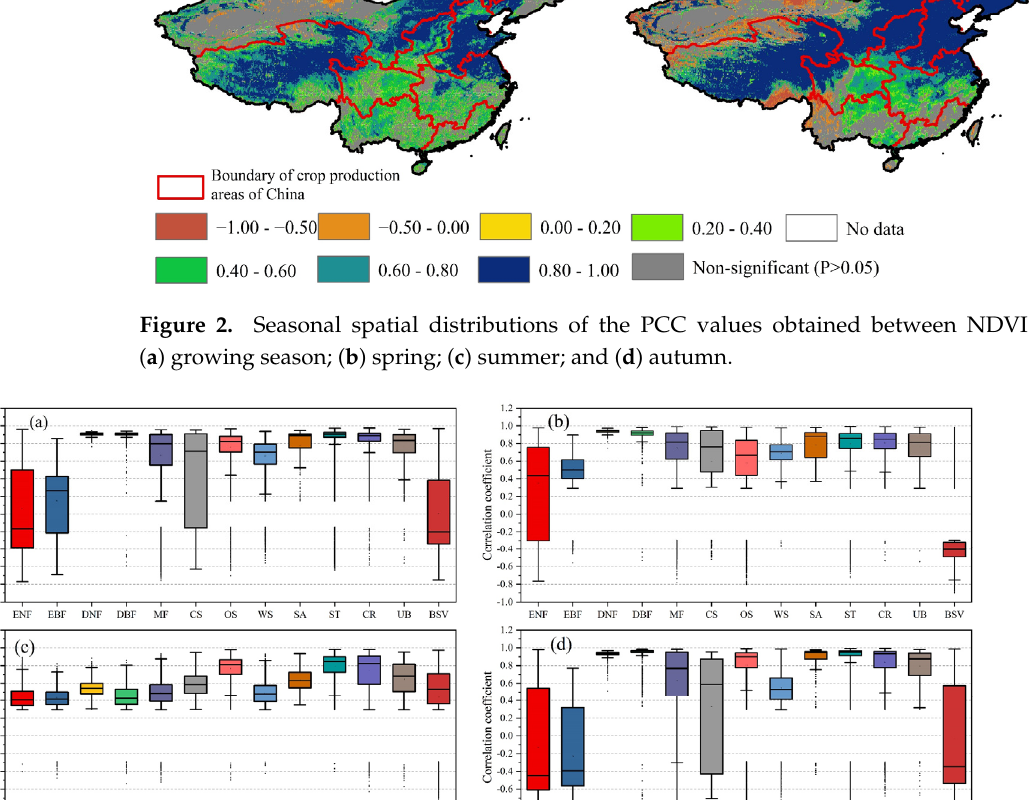
Figure 4. Spatial distributions of the correlations between GPP and SIF ( a . growing season; b . spring; c . summer; and d . autumn) and between GPP and NDVI ( e . growing season; f . spring; g . summer; and h . autumn). To further analyze the relationships between the SIF (NDVI) and the GPP, the cor- relations between the SIF (NDVI) and the GPP were calculated for different land-cover types, as shown in Figure 5. As shown in Figure 5a, during the growing season, the SIF and the GPP showed relatively strong correlations for most of the land-cover types ex- cept for the EBF and the BSV; the NDVI and GPP also showed high correlations for most of the land-cover types except for the ENF, EBF, and CS. However, the PCC values de- rived between the SIF and the GPP were essentially greater and less variable than those